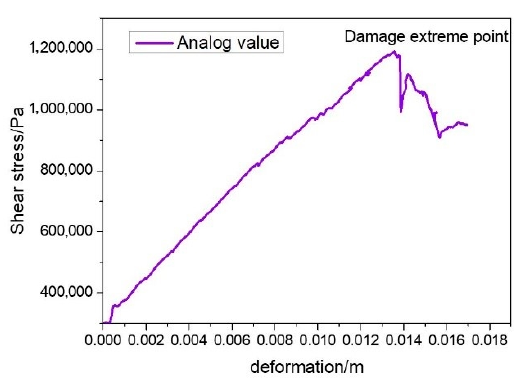
Figure 13. The simulation results.